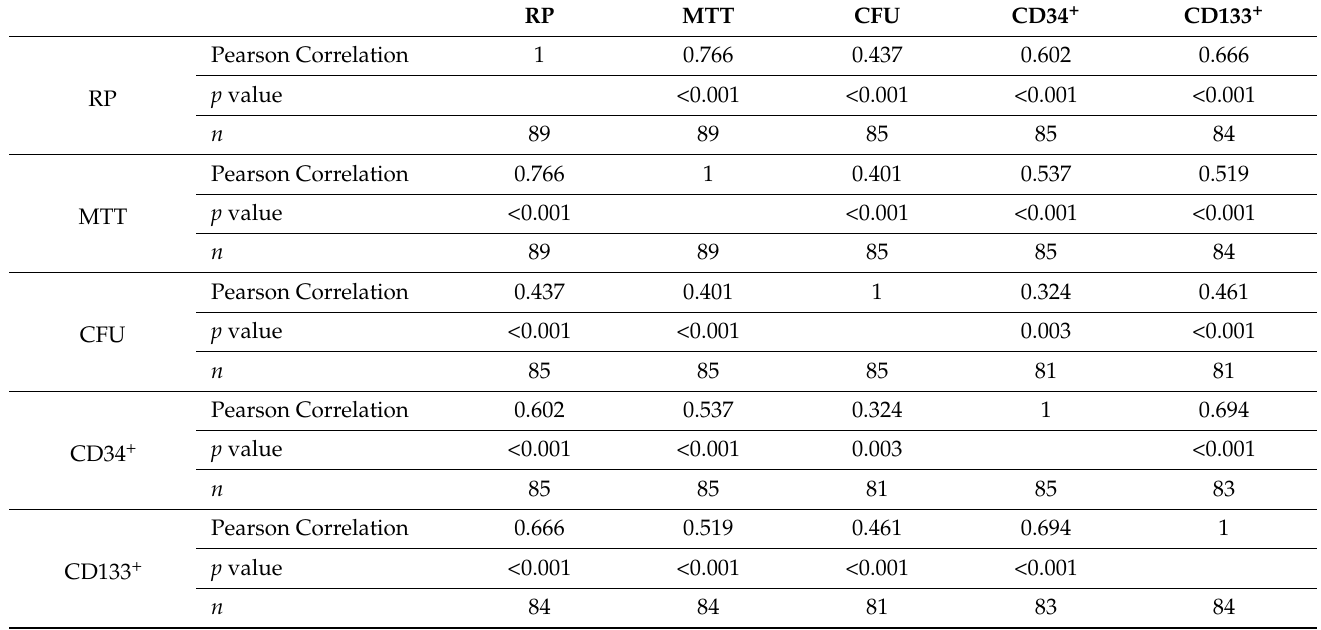
Figure 3. Correlation for the four EPC markers and RP quantity at baseline. CFU = colony-forming units; Table 4. Correlation between RP and EPC markers at baseline